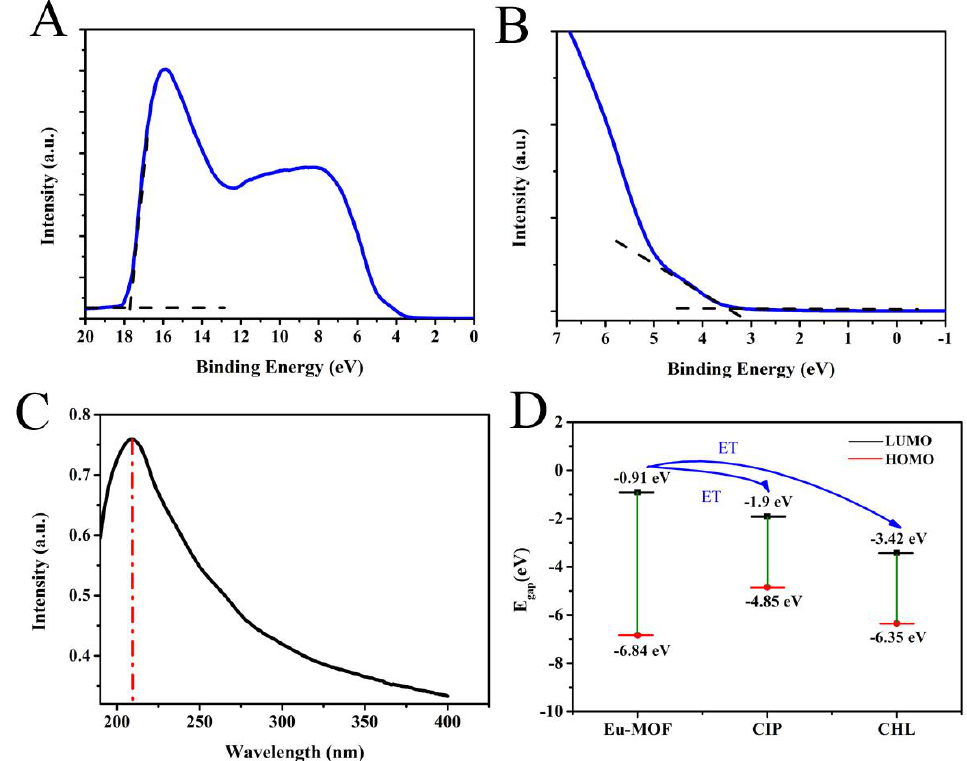
Figure 3. UPS spectra of Eu − MOF in ( A ) the second edge region and ( B ) the HOMO region; ( C ) UV absorption spectra of Eu − MOF; ( D ) HOMO − LUMO energy levels and molecular front orbital energy levels of Eu − MOF and CIP and CHL.